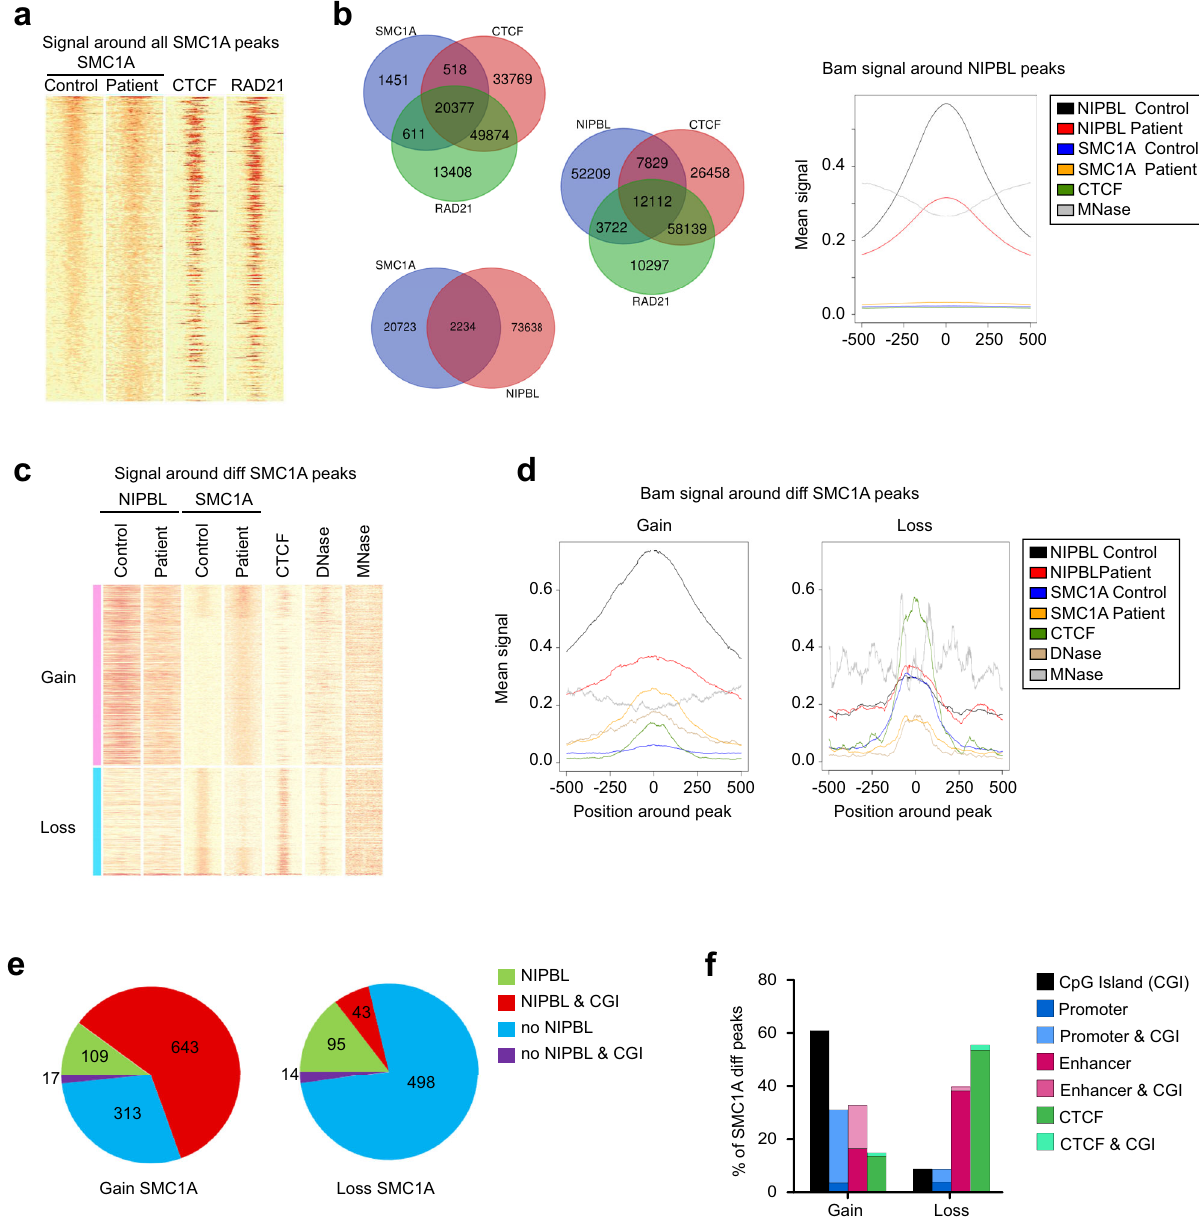
Fig. 5 Genome-wide distribution of SMC1A in CdLS-derived cells. a Heatmap showing the signal around all SMC1A peaks in control and CdLS patient 3- derived cells and its colocalization with CTCF and RAD21. b (left) Venn diagrams showing the overlap of genomic positions of SMC1A (dark blue) with CTCF (light red) and RAD21 (green) (up), SMC1A (dark blue) with NIPBL (light red) (bottom) or NIPBL (dark blue) with CTCF (light blue) and RAD21 (green) (right). b (right) Bam graph showing the mean signal of NIPBL (Control, black; Patient, red), SMC1A (Control, blue; Patient, orange), CTCF (green), and MNase (gray) around NIPBL peaks in control and CdLS patient 3-derived cells. c Heatmap comparing the signal in control and CdLS patient 3-derived cells around differential SMC1A peaks. Signals of SMC1A, NIPBL, CTCF, DNase, and MNase genomic distribution are depicted. The heatmap is divided into two categories, SMC1A peaks gained (pink) or lost (light blue) in the patient compared with the control. d Bam graphs showing mean signal of the indicated proteins around gained (left) and lost (right) SMC1A genomic positions. NIPBL (Control, black; Patient, red), SMC1A (Control, blue; Patient, orange), CTCF (green), DNase (brown), and MNase (gray). e Pie charts showing the overlap of gained (left) and lost (right) SMC1A peaks with NIPBL and CpG islands (CGI). NIPBL, green; NIPBL&CGI, red; no NIPBL, blue; no NIPBL&CGI, violet. f Plots of percentages of SMC1A gained and lost peaks overlapping with CpG islands (CGI, black), promoters (blue), enhancers (pink), and CTCF Reduction of chromatin contacts in CdLS patient-derived from our control sample SMC1A ChIP-seq with published Hi-C fi broblasts . Using a computational method previously experimental loops for IMR90 with a median loop size of 239 kb described 77 we predicted 3D-looped intra-TAD structures based on CTCF motif orientation (1D) and CTCF and cohesin ChIP- (IQR 290 kb) containing a CTCF motif within both their seq binding strength data (2D). To validate the method, we boundaries (Supplementary Data 10). On the other hand, we compared the in silico predicted intra-TAD loops using the data predicted 17,461 TADs in silico from the control sample with